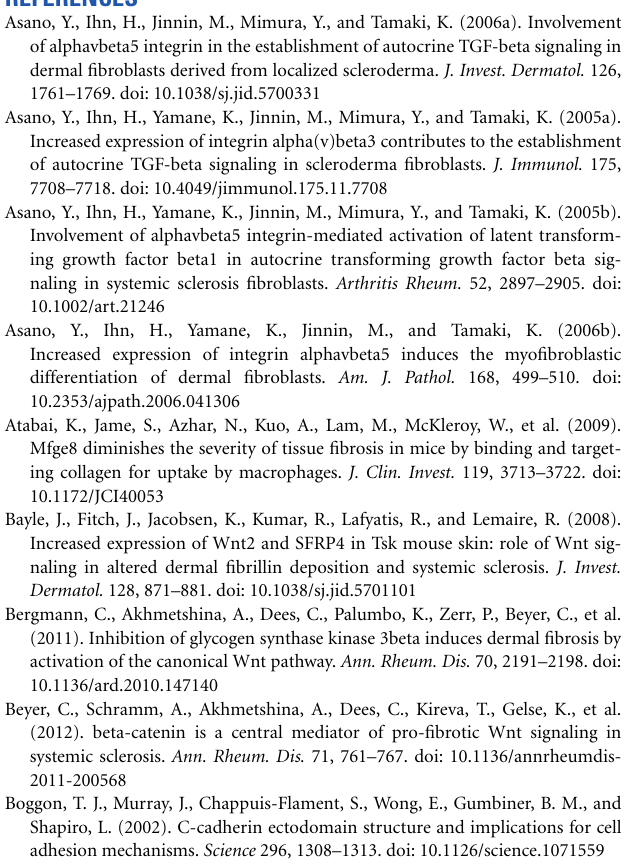
alveolar macrophages, and injured type II alveolar epithelial cells. Cadherin-11 likely contributes to fibrosis through regulation of fibroblast migration, alveolar macrophage production of TGF β , and mesenchymal gene expression and possibly EMT of type II